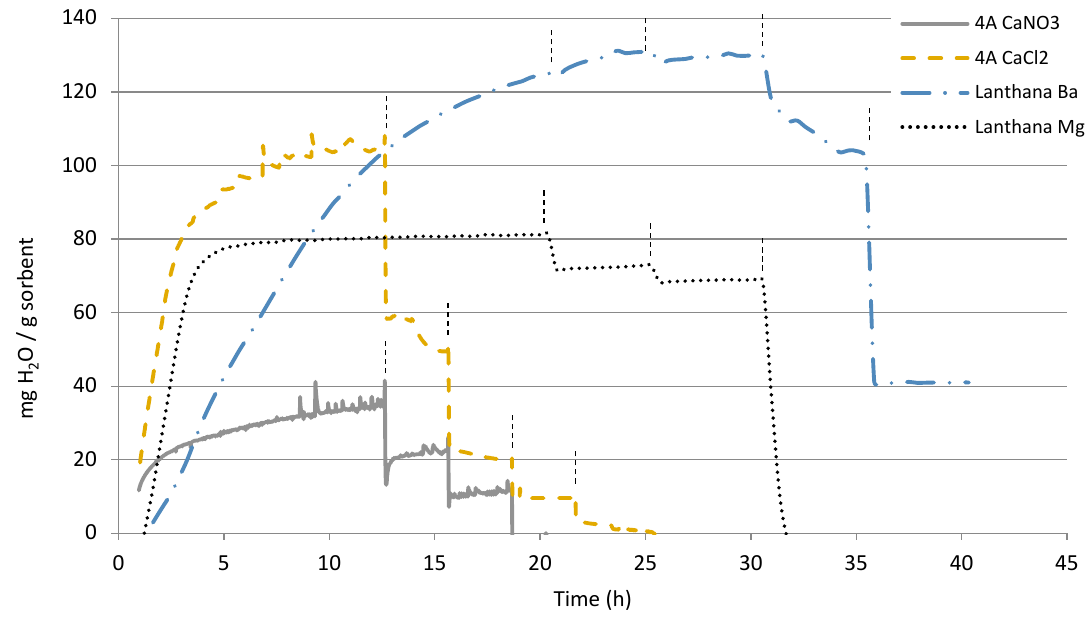
Figure 5. Water sorption capacity of the calcined and modified zeolite 4A and lanthana. The vertical lines in each graph indicate the temperature change: 25 ◦ C, 100 ◦ C, 200 ◦ C, 300 ◦ C and 400 ◦ C. Table 1. Maximum water sorption capacity (mg of adsorbed water per sorbent g) reached at different temperatures for all the tested calcined sorbents.